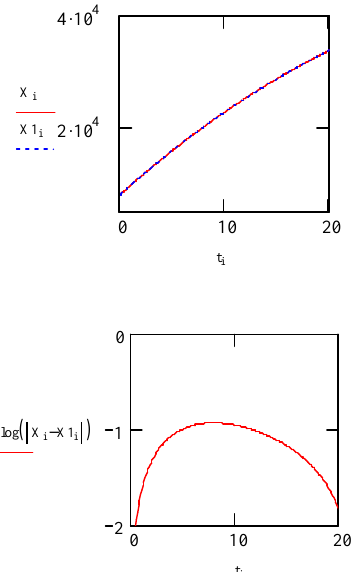
Comparison of the estimated solutions, X i , with the “experimental data” and the absolute error in the decimal logarithmic scale.